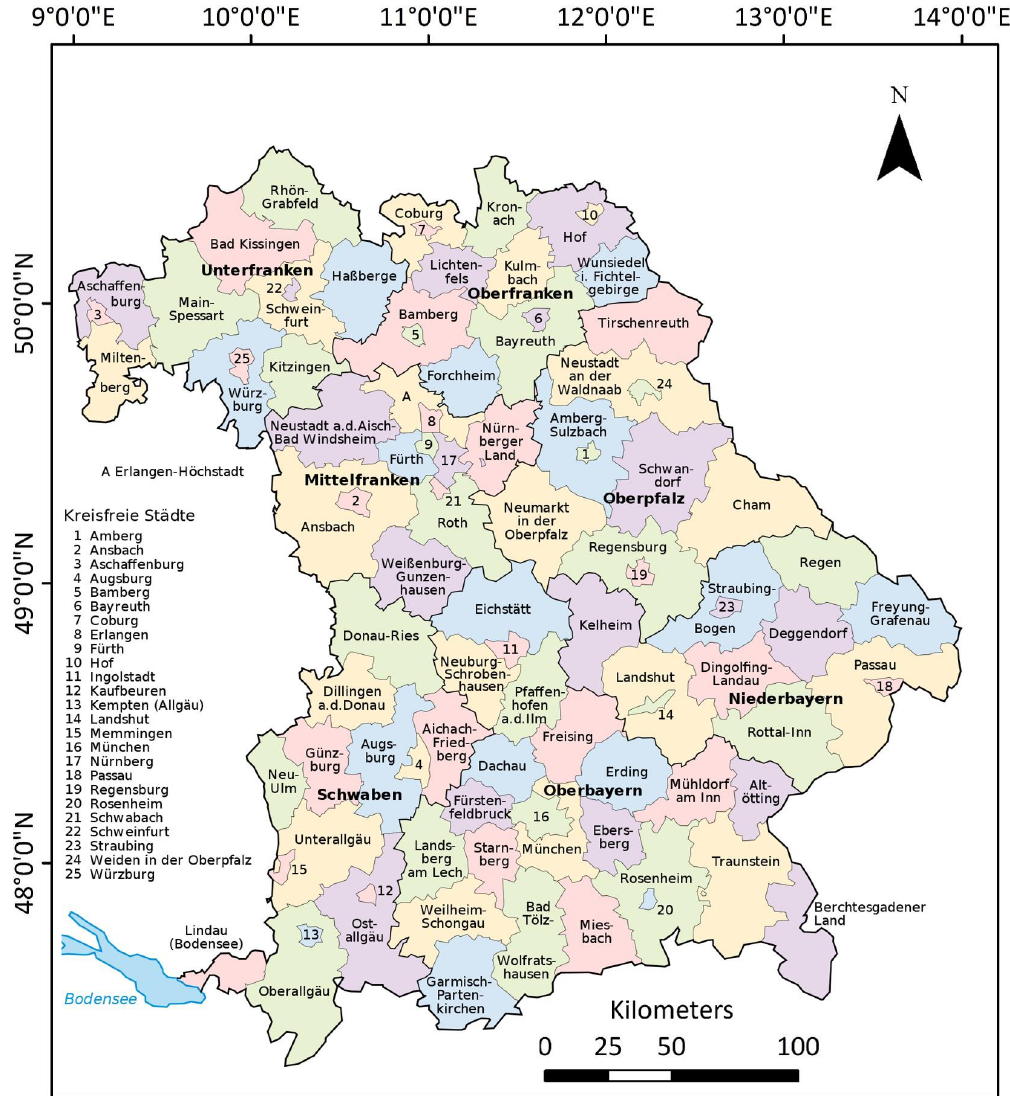
Figure A1. Detailed map of administrative regions of Bavaria (Landkreise und kreisfreie Städte in Bayern). The names of the districts are translated from German to English as: Unterfranken as Lower Franconia, Mittelfranken as Middle Franconia, Oberfranken as Upper Franconia, Oberpfalz as Upper Palatinate, Oberbayern as Upper Bavaria, and Niederbayern as Lower Bavaria. (Source: https://www.gifex.com/, accessed on 12 January 2023).